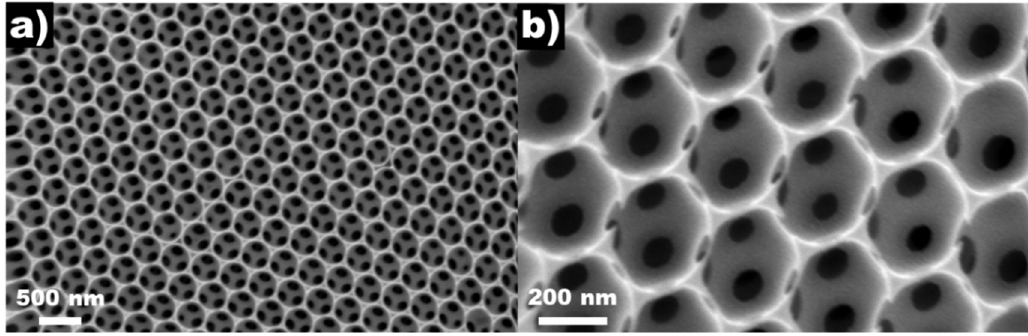
Figure 1. SEM images of the as-prepared PC FTO photoelectrode at ( a ) low magnification and ( b ) high magnification.